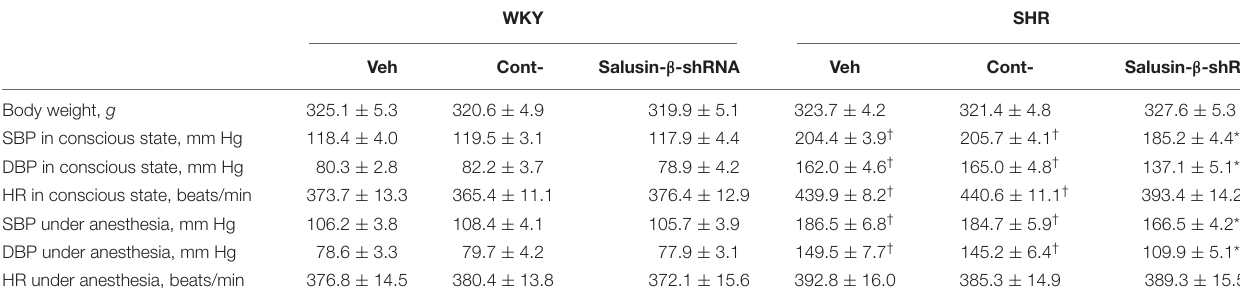
TABLE 1 | Effects of salusin- β knockdown on body weight, SBP, DBP, and HR in WKY and SHR in conscious state or under anesthesia. WKY SHR Veh Cont- Salusin- β -shRNA Cont- Salusin- β -shRNA